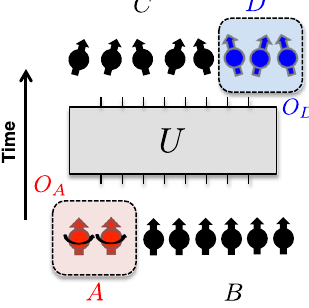
FIG. 2. Schematic image of the setup associated with an out-of- time-ordered correlation function, h O A ð 0 Þ O D ð t Þ O A ð 0 Þ O D ð t Þi . Time runs upward and evolution is generated by the unitary U . The Hilbert space decomposes as H ¼ H A ⊗ H B ¼ H C ⊗ H D . Ideally, operators O A and O D act on sufficiently small subsystems of the full